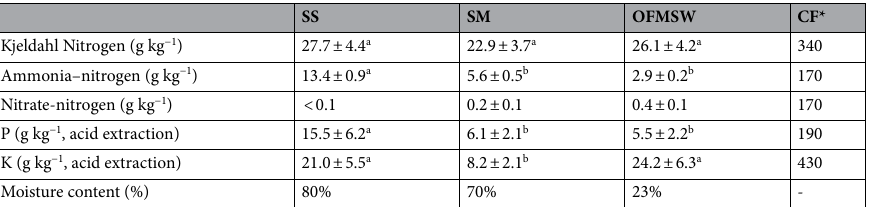
Table 1. Chemical composition in dry weight of organic fertilizers (n = 3). Samples were analysed in triplicate. Different lowercase letters indicate statistically difference ( p < 0.05). The amount of fertilization product added per pot was calculated to ensure the same quantity of total nitrogen in all treatments (100 kg of N per ha). *Chemical fertilizer composition was as follows: ammonium nitrate (34% N), phosphate (44% P 2 O 5 ) and potassium sulfate (52% K 2 SO 4